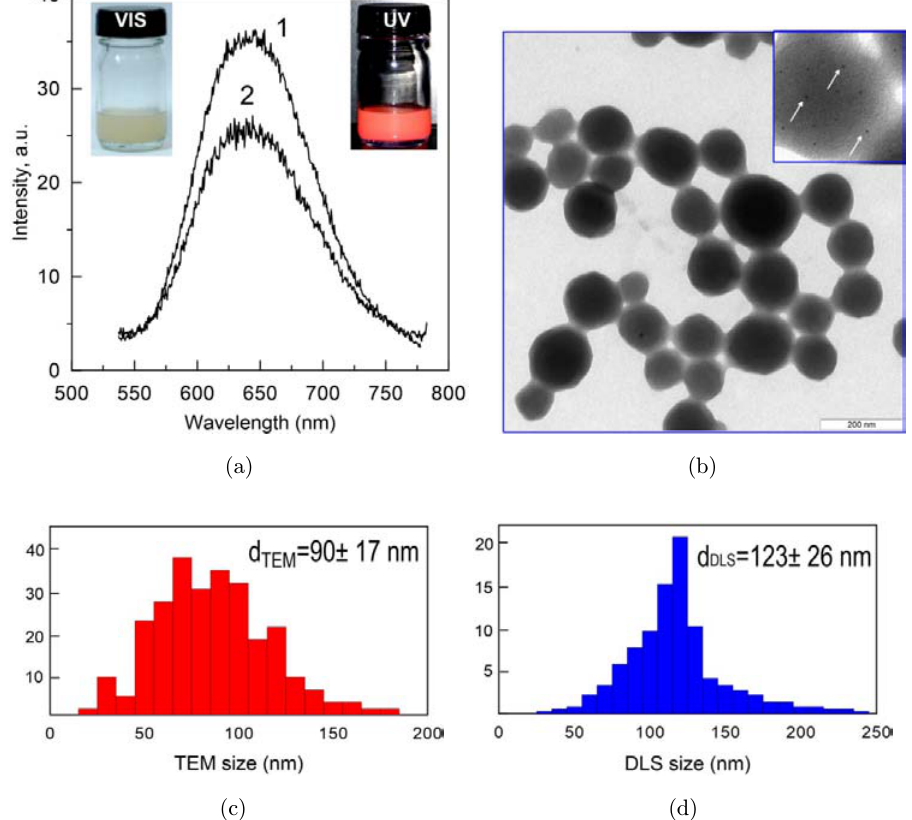
Fig. 2. (a) FL spectra of diluted (1:100) Au – HSA NCs (curve 1) and NC-loaded nanoparticles (curve 2). The insets show images of nanoparticle suspensions under vis (left) and UV (right) illumination. (b) TEM image of the nanoparticles. The inset shows a magni¯ed image of a single nanoparticle. The arrows indicate the position of the Au – HSA NCs in the protein nanoparticles. (c) Histogram of the nanoparticle size distribution obtained by TEM measurements. (d) Histogram of the nanoparticle size distribution obtained by dynamic light scattering (DLS)